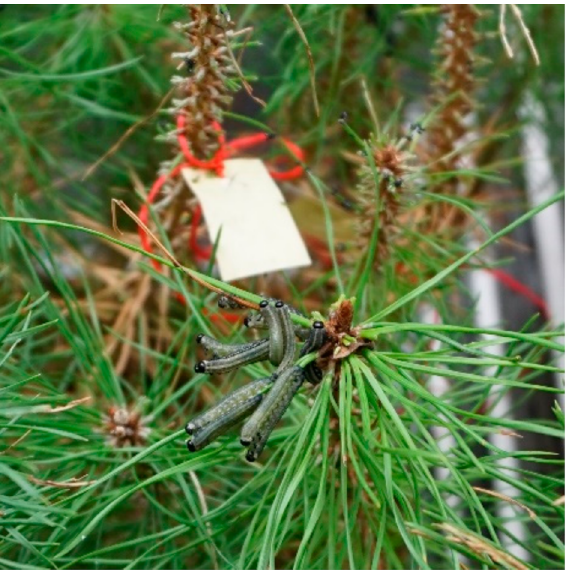
Figure 5. European pine sawfly ( N. sertifer ) larvae and their caused damage on the control seedlings. After inoculation with L seditiosum , 60 needles from a selection of the 162 surviving seedlings (77 control and 85 MeJA-treated seedlings), were sampled once a month and analyzed with L. seditiosum -specific primers. No brown lesions (caused by L. seditiosum ) or positive PCR results were observed until 3 months post inoculation. After the first positive PCR results, needles from all seedlings were tested. Lophodermium seditiosum was detected by PCR in 62 individuals of the analyzed needle samples of all control seedlings and